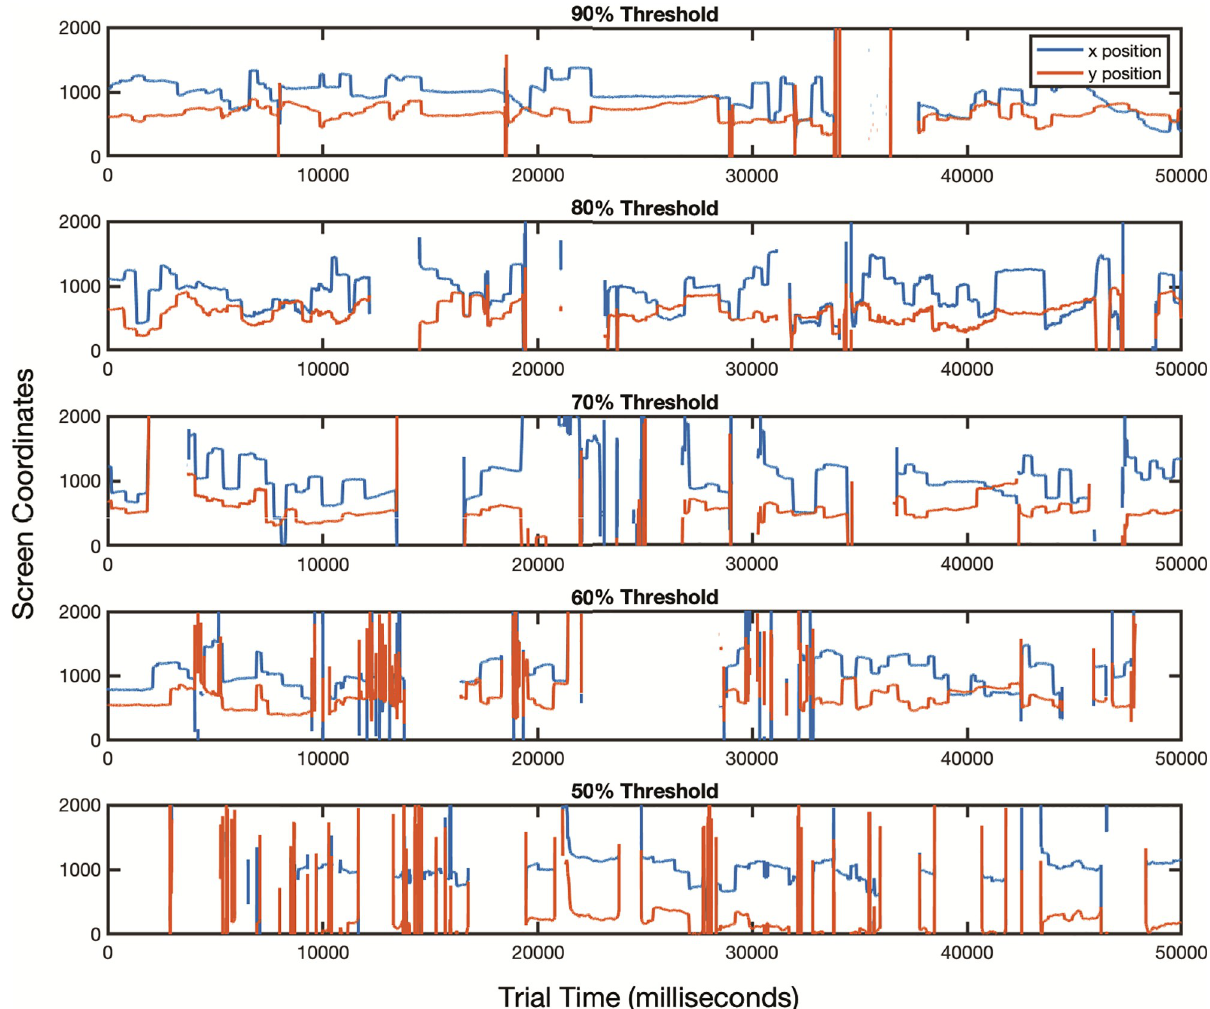
Fig 8. Sample trials of raw data. Raw data are shown from different participants for whom decreasing levels (from top to bottom) of valid data were collected. X and Y eye positions are shown in blue and orange, respectively. Horizontal plateaus are periods where x and y coordinates of the eye remain relatively steady, indicating fixations. Vertical lines are periods where the eye position is changing rapidly, indicating saccades. Gaps in the traces represent periods of data loss. As the threshold for valid data decreases, there are more frequent gaps in the data and increased noise in the x,y traces.